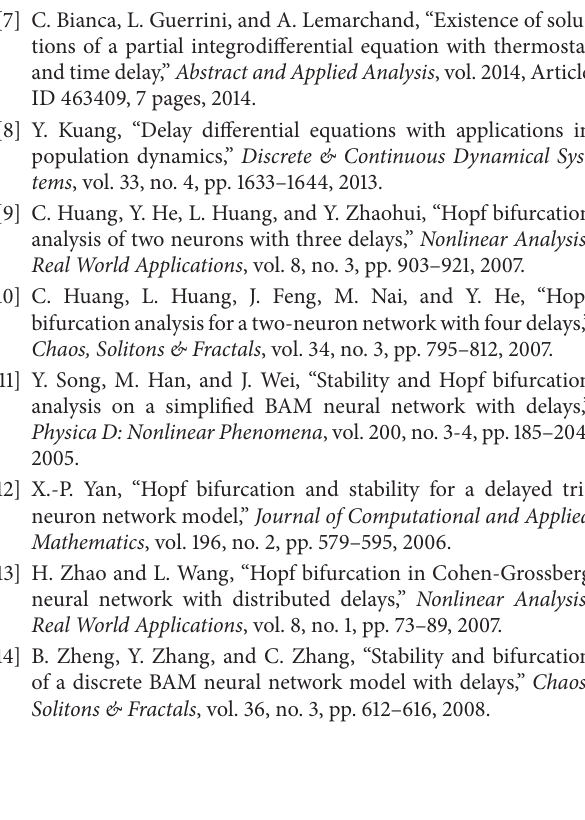
form theory and the center manifold reaction. A challenging perspective is the comparison of the generalized model introduced in the present paper with the experimentally mea- surable quantities. Indeed, the mathematical models should reproduce both qualitatively and quantitatively empirical data (see